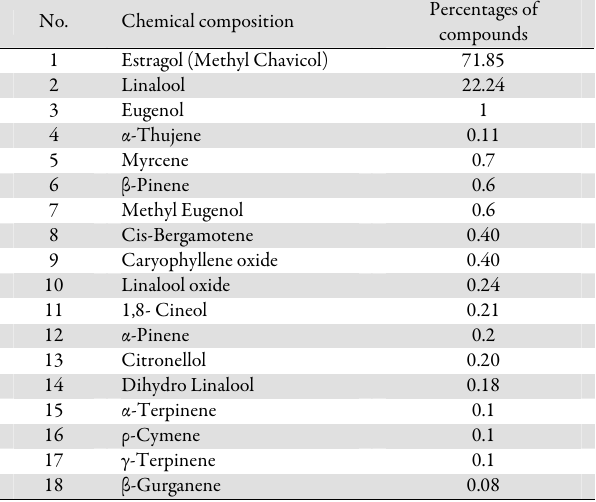
456 Tab. 1. Chemical composition of the O. basilicum essential oil